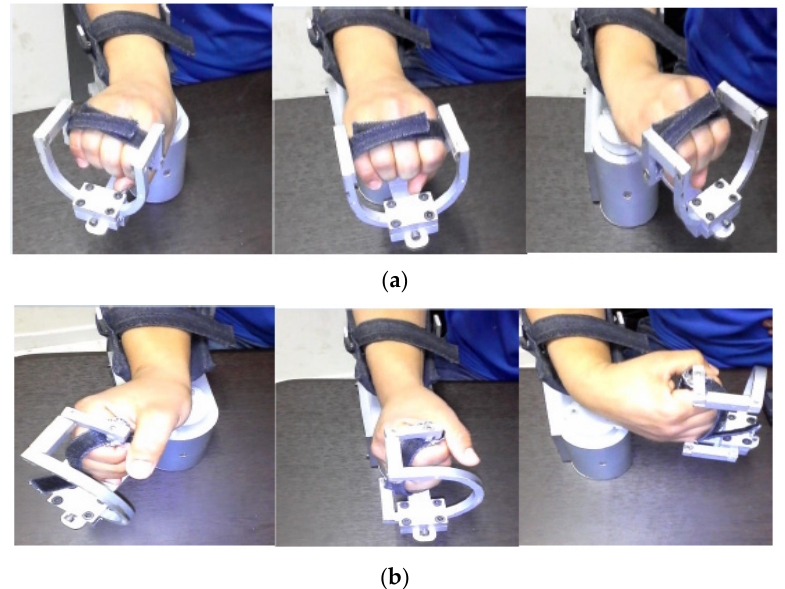
Figure 3. ( a ) Abduction/adduction movement; ( b ) Flexion/extension movement. Table 1 . Mechanical components .